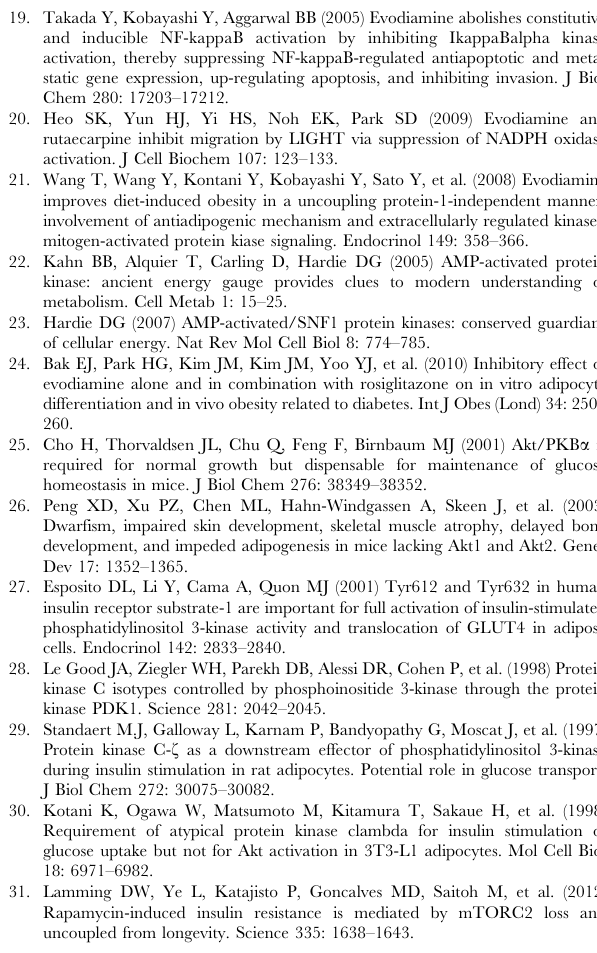
on phosphorylation of ERK, Akt and IRS1 in pre-adipocytes. 3T3-L1 pre-adipocytes were serum-deprived for 4 h and then treated with 20 m M evodiamine for 1 h and with 20 nM insulin for the last 10 min. Western blot analysis for ERK, Akt and IRS1 were done with cell lysates (30 m g protein). Figure S6, Measure- ment of oxygen consumption (VO 2 ) and respiratory quotient